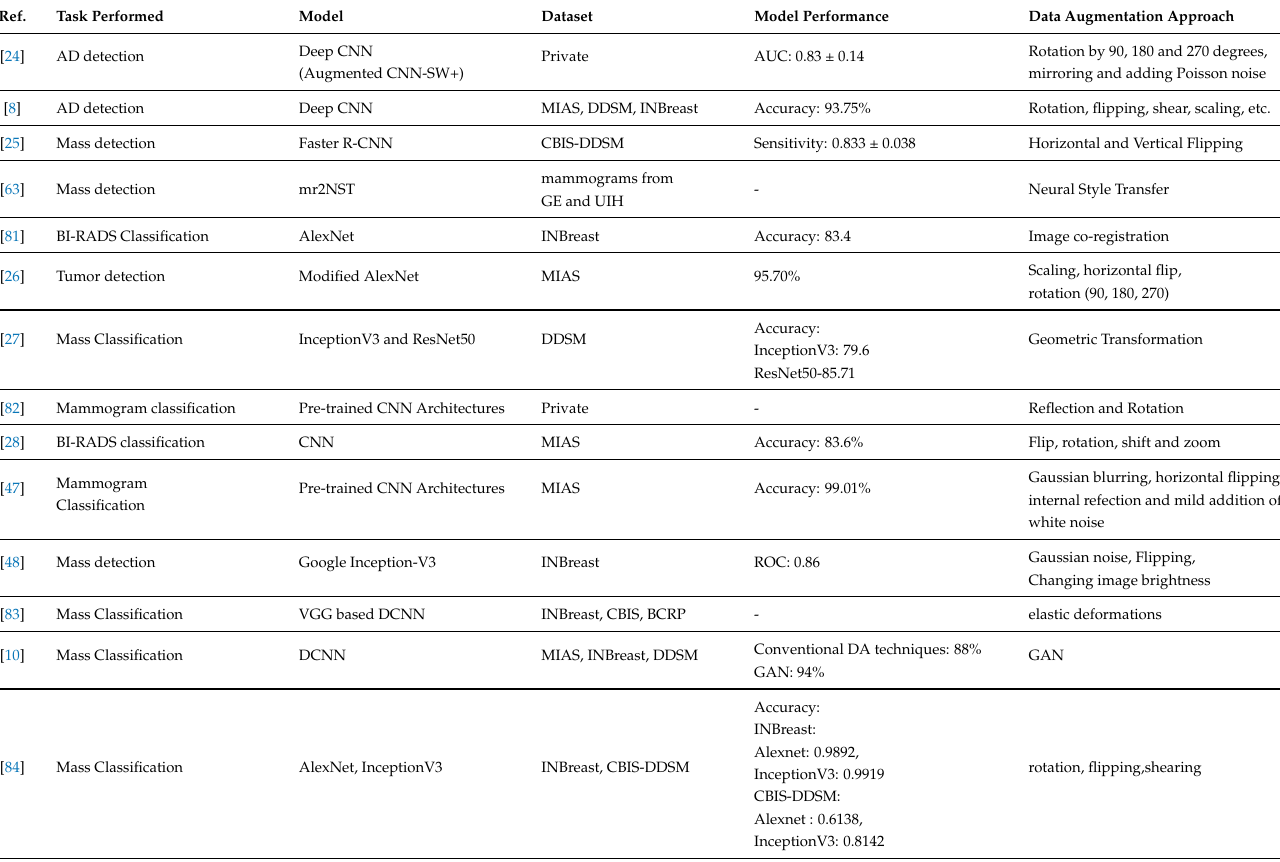
Table 2. Summary of articles using Image